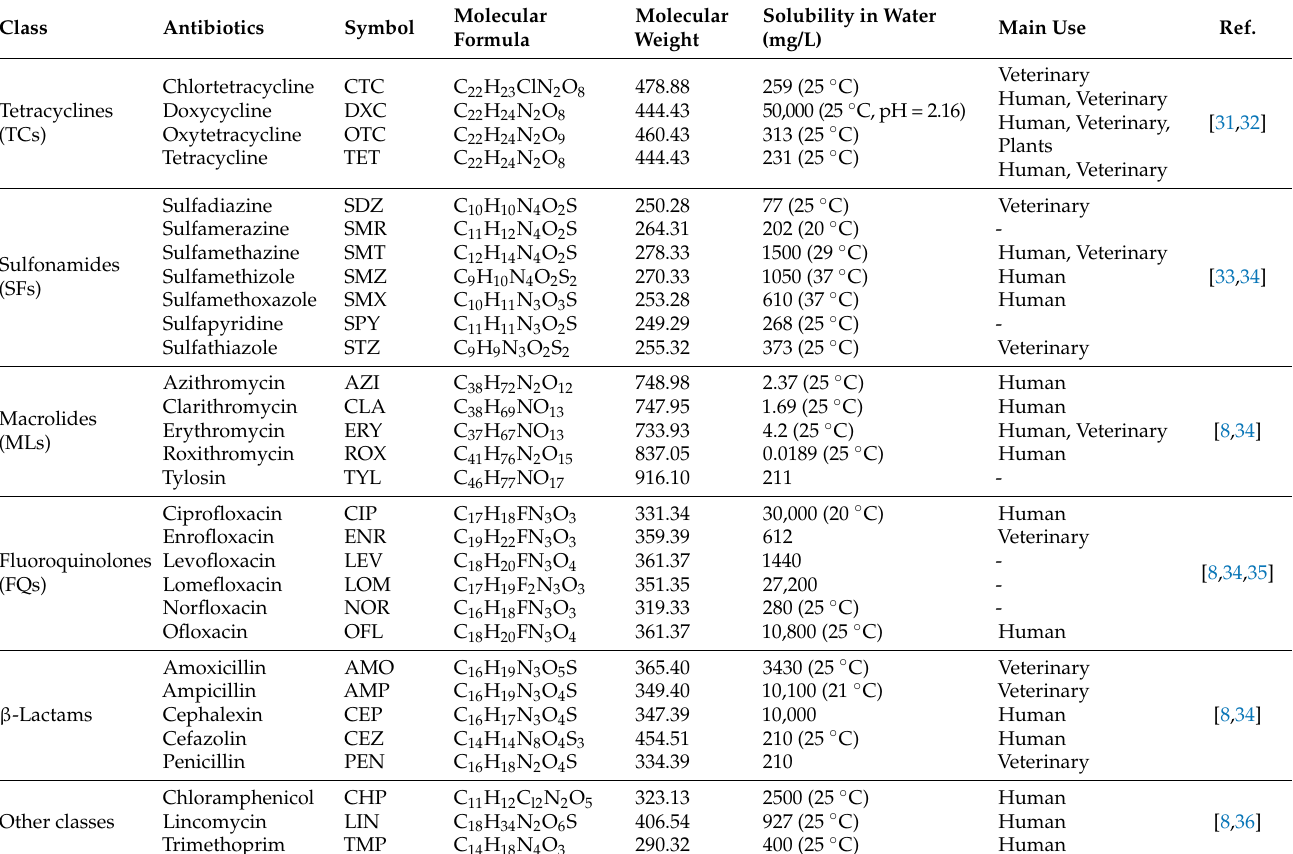
Table 1. Physicochemical properties of the most common